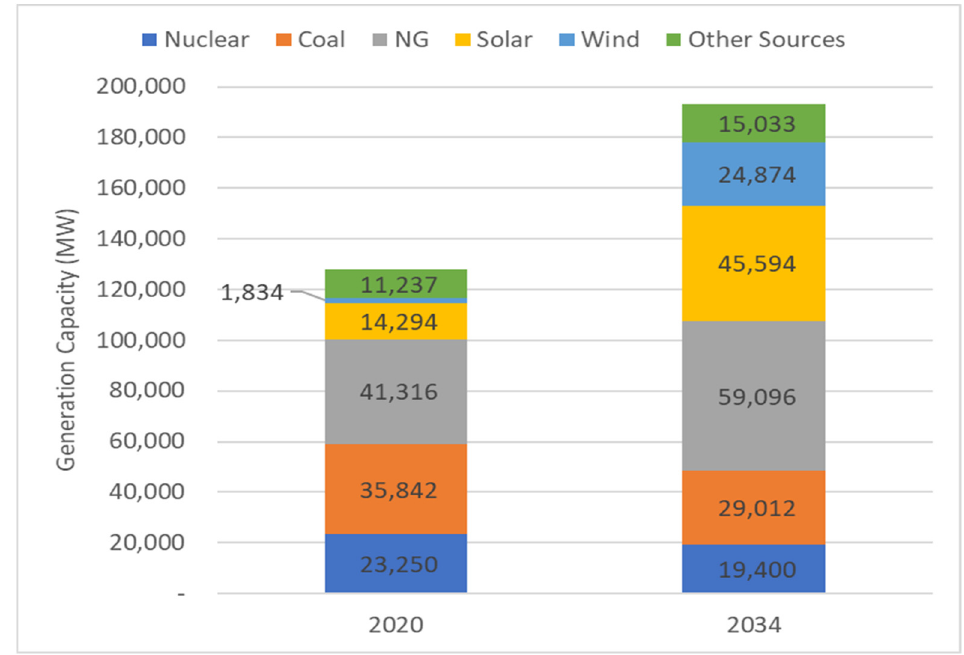
Figure 1. Composition of generation capacities, 2020 vs. 2034.